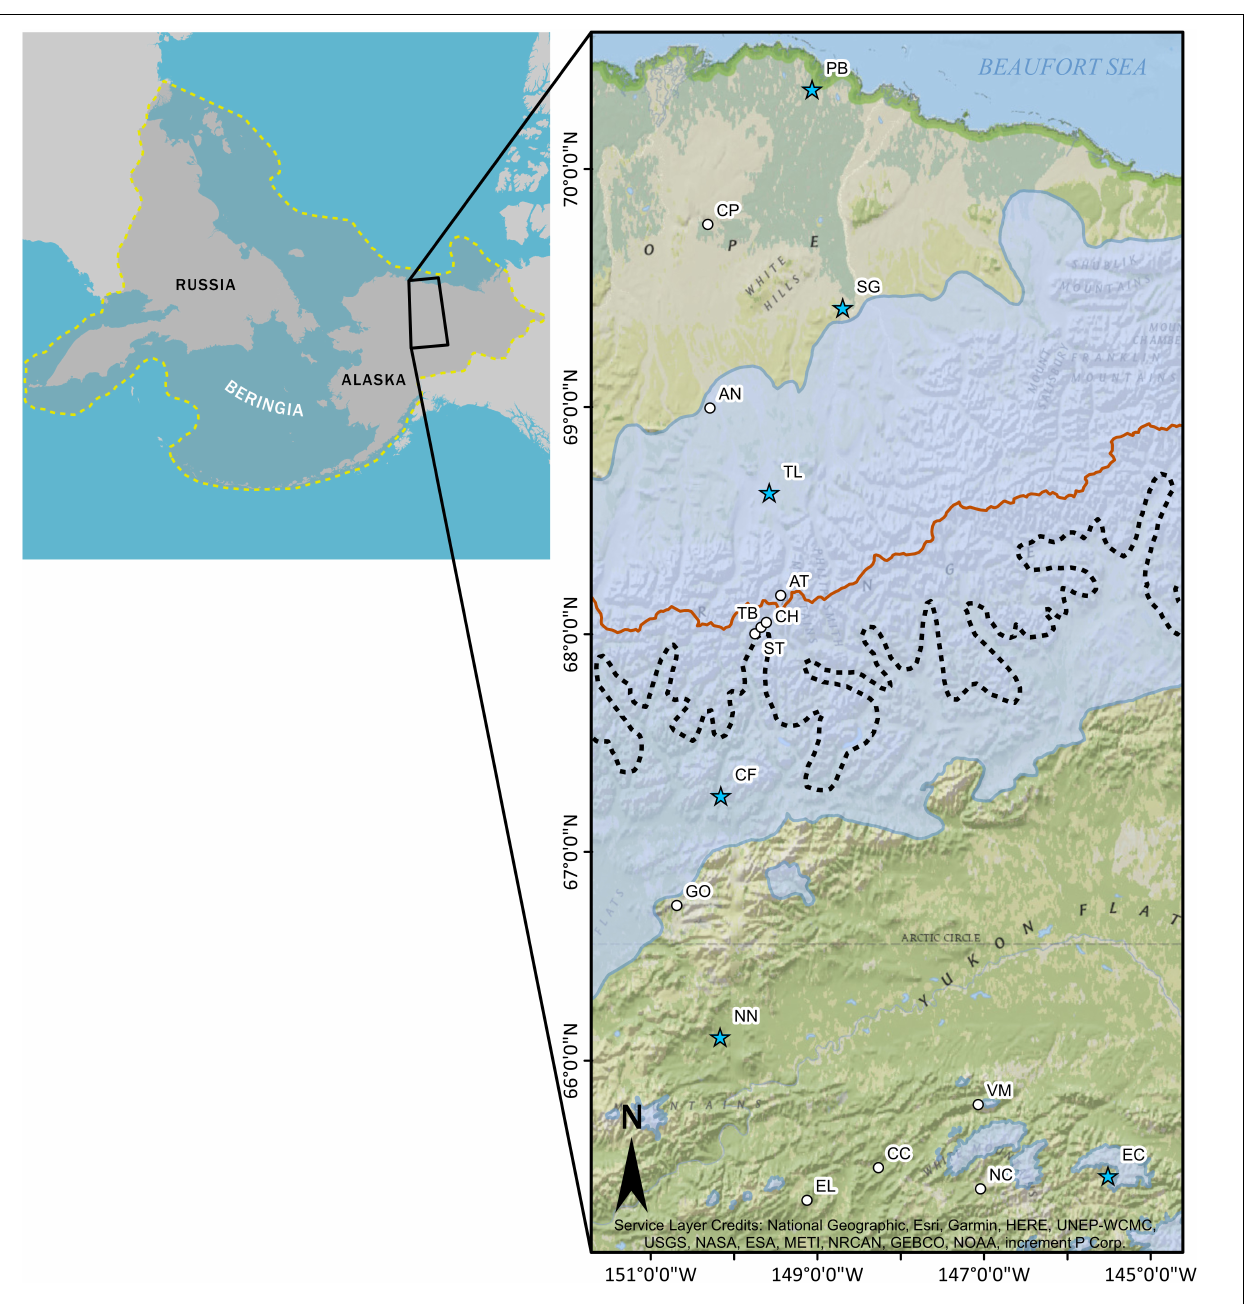
FIGURE 1 | Map of Eriophorum vaginatum sampling locations and modeled maximum Pleistocene glacial extent (Kaufman and Manley, 2004; Kaufman et al., 2011) along a latitudinal gradient in north central Alaska. Blue stars designate reciprocal transplant gardens (Shaver et al., 1986; Bennington et al., 2012). Treeline is indicated by the dashed black line and the Continental Divide is indicated by the burnt orange line. The inset shows the extent of the Beringian region, outlined with a dashed yellow line. The 17 collection site abbreviations are as for Table 1